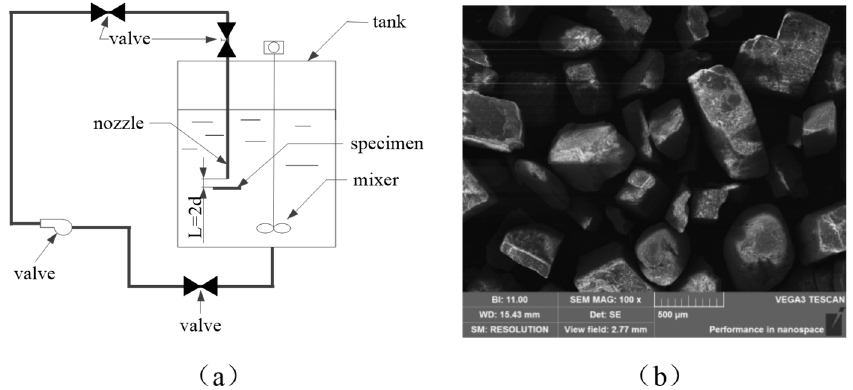
Figure 2. Schematic diagram of experimental device and micromorphology of sand used in the experiment. ( a ) Schematic diagram of experimental device ( b ) micromorphology of sand